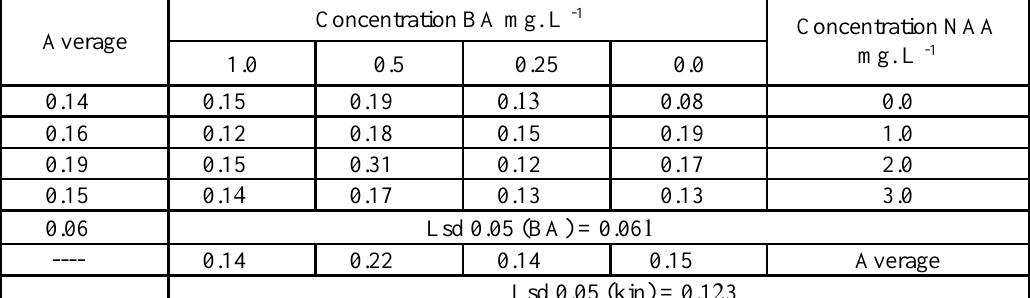
Table 7. Effect of BA and NAA auxin and their interaction on average dry weight (gm)